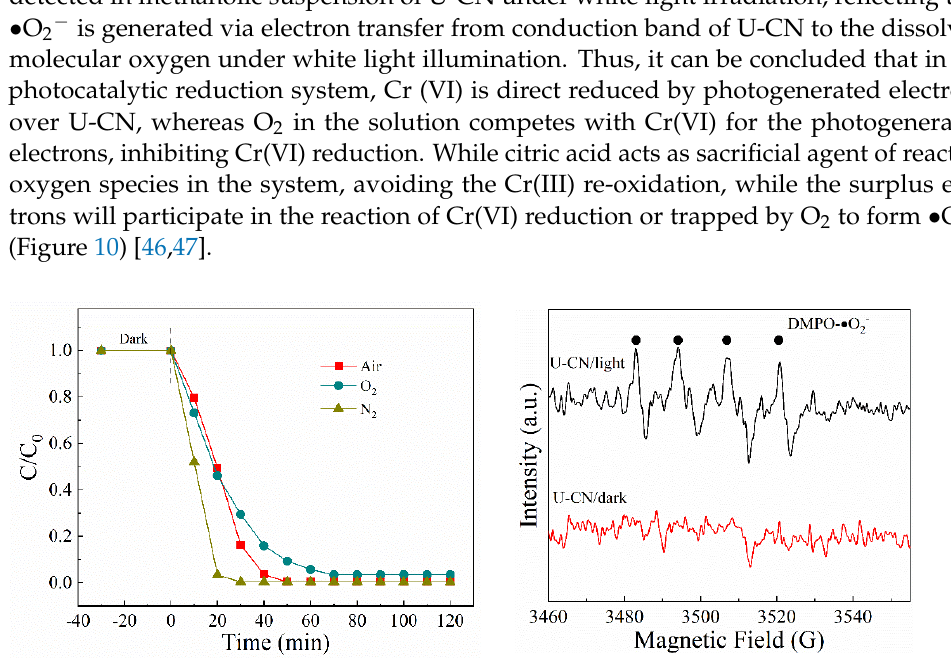
Figure 10. Proposed mechanism for photocatalytic reduction of Cr(VI) over U-CN. 3. Materials and Methods 3.1. Materials and Instruments Melamine, dicyandiamide, thiourea, urea, potassium dichromate(K 2 Cr 2 O 7 ), acetone, sulfuric acid(H 2 SO 4 ), phosphoric acid(H 3 PO 4 ), diphenyl carbonyl hydrazine, sodium hy- droxide(NaOH), methyl alcohol, oxalic acid, formic acid, citric acid, and tartaric acid were all analytical grad and obtained from Chron Chemical Reagent Co., Ltd. (Chengdu, China.) Furthermore, 5,5-dimethyl-1-pyrroline N-oxide(DMPO) was supplied by the Aladdin Industrial Corporation (Shanghai, China). All the reagents were analytically pure and the solutions were prepared using ultrapure water. 3.2. Preparation of Graphitic Carbon Nitride (g-C 3 N 4 ) The g-C 3 N 4 samples were synthesized by a thermal polymerization method using dicyandiamide, melamine, thiourea, and urea as precursors. Typically, 10 g of the precur- sor powder was put into an alumina crucible and heated at 5 °C/min up to 550 °C for 3 h in a covered muffle furnace. After the crucible cooling to room temperature, four products were collected and ground into powder. The obtained products were named as D-CN, M- CN, T-CN, and U-CN, respectively (Figure S1, Supplementary Materials). 3.3. Photocatalytic Experiments The photocatalytic activity of the synthesized samples for the removal of Cr(VI) was evaluated under white light provided by a Xe light with the power of 300 W (Perfectlight). At room temperature a certain amount of g-C 3 N 4 was suspended into 150 mL aqueous solution of Cr(VI) (50 mg/L) with the addition of citric acid (0.9 mM). The solution pH was adjusted to 3 by H 2 SO 4 (1 M) or NaOH (1 M). Prior to irradiation, the suspension was